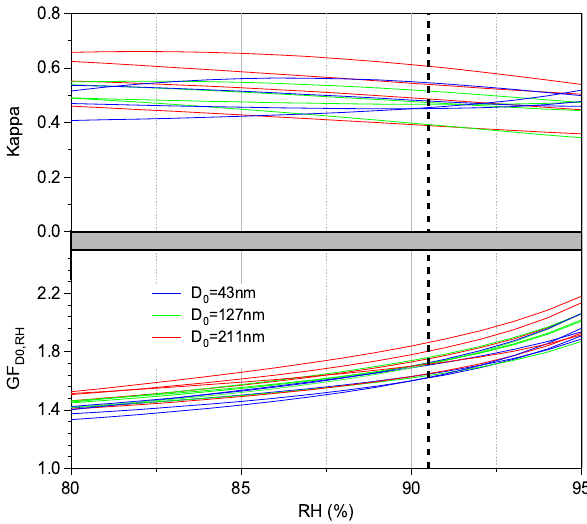
Fig. 9. Measured growth factors and derived κ as a function of RH. The top panel shows the κ values derived from the humidograms. The bottom panel shows the fitted humidograms for RHs between 80% and 95%. The dashed line indicates the highest RH the HT- DMA measures at.